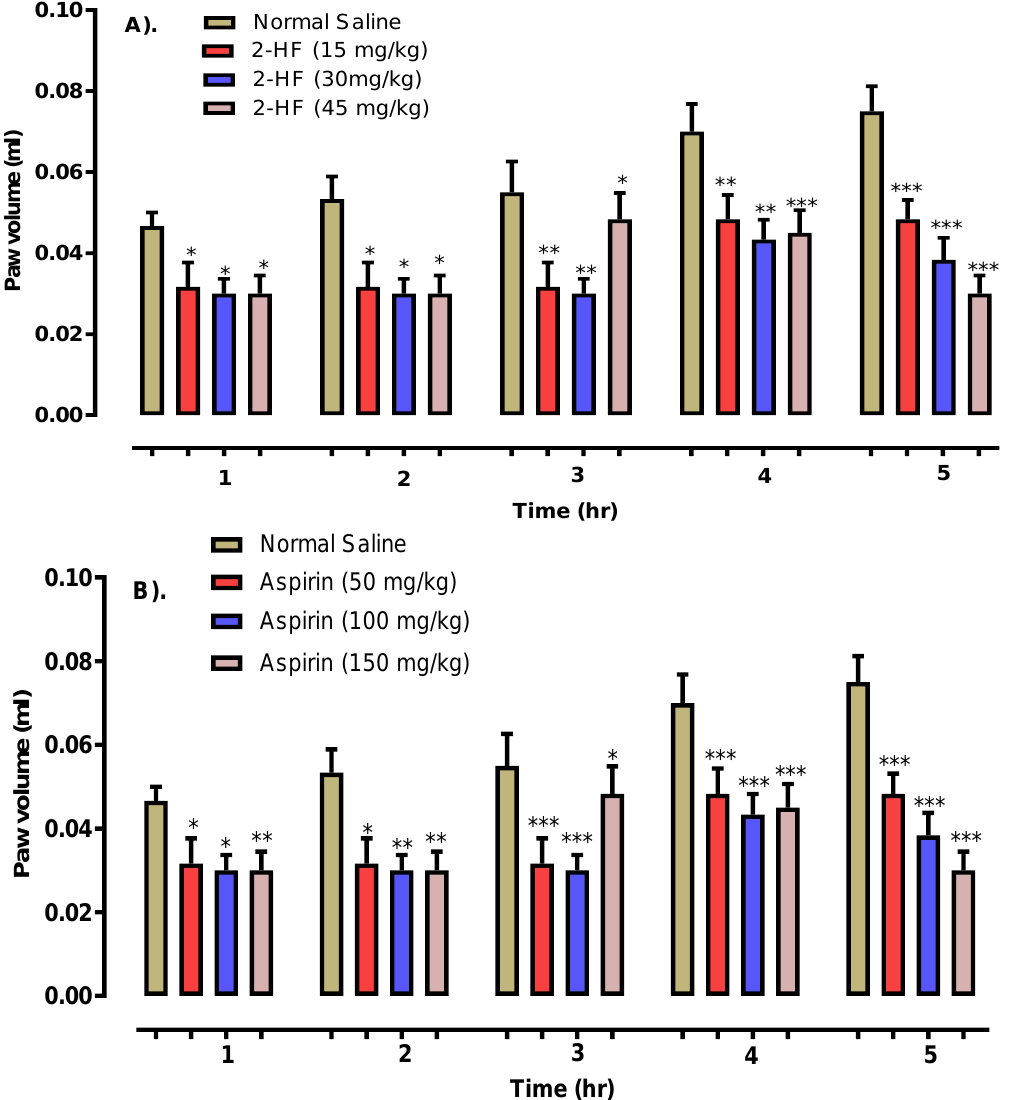
Figure 7. Results of the anti-inflammatory potentials of 2-HF in histamine-induced paw edema model. ( A ). Anti-inflammatory activity of 2HF at 15, 30 and 35 mg/kg dose. ( B ). Anti-inflammatory activity of Aspirin at 50, 100 and 150 mg/kg dose. *** p < 0.001, ** p < 0.01, * p < 0.05 in comparison to saline treated group, two-way repeated measures ANOVA followed by Tukey’s post hoc